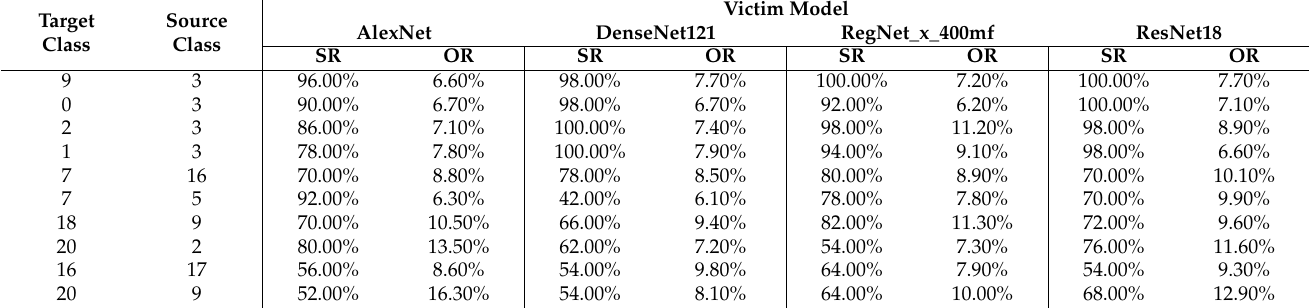
Table 4. TSR of STUAE on UCM with four victim models: AlexNet, DenseNet121, RegNet_x_400mf, and ResNet18. The goal of adversaries is to mislead victim models to recognize images from the source class to the target class . SR (the higher, the better) stands for the ratio of images from the source class to be predicted as the target class, while OR (the lower, the better) stands for the ratio of images from the other classes to be predicted as the target